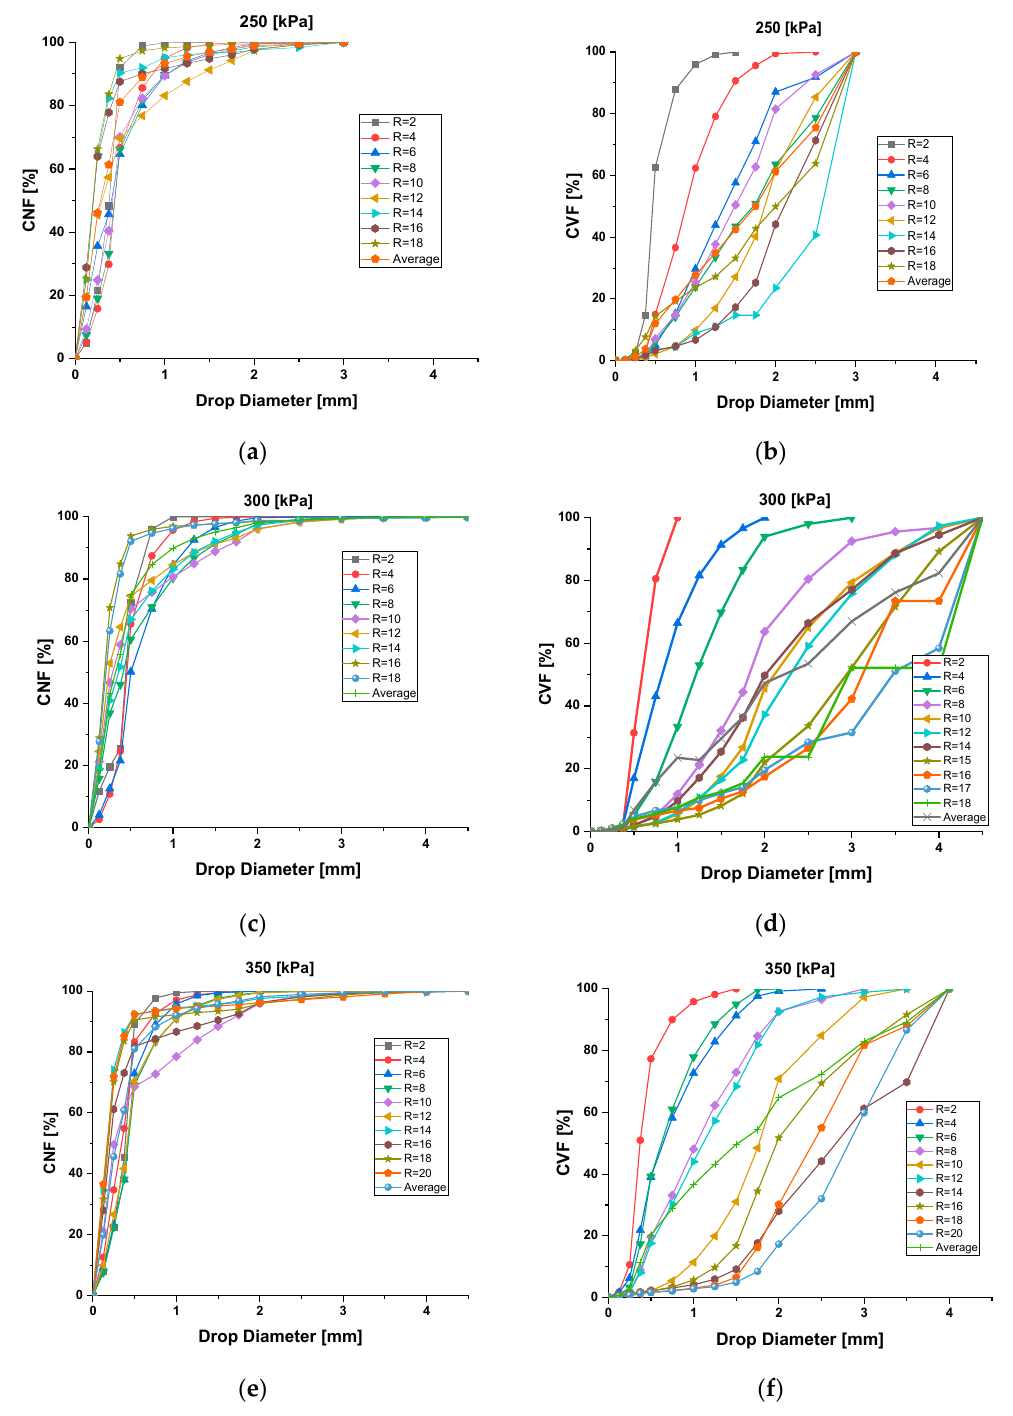
Figure 4. Plot of cumulative numeric frequency (CNF) (%) and cumulative volumetric frequency (CVF) (%) against the diameter of drops (mm) at 250 kPa, 300 kPa, and 350 kPa respectively. Where ( a ) is CNF vs. Drop diameter at 250 kPa; ( b ) CVF vs. Drop diameter at 250 kPa; ( c ) CNF vs. Drop diameter at 300 kPa; ( d ) CVF vs. Drop diameter at 300kPa; ( e ) CNF vs. Drop diameter at 350 kPa; ( f ) CVF vs. Drop diameter at 350 kPa.